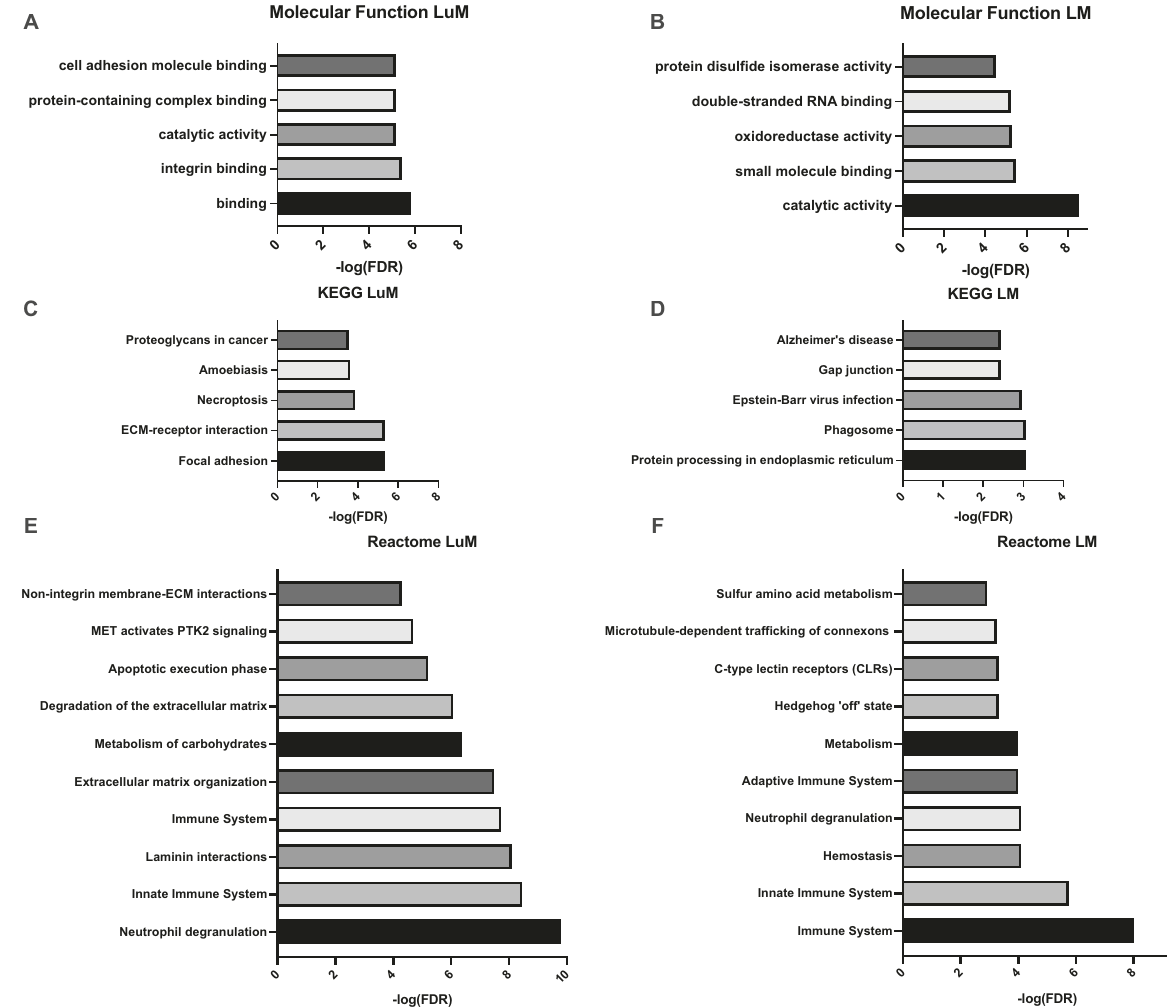
Fig. 5 Molecular function and pathway (KEGG and REACTOME) annotations of LM and LuM CD11b + cells. LuM and LM proteins were annotated for Molecular function ( A , B ), KEGG ( C , D ), and Reactome Pathways ( E , F ), respectively. Druggable proteins with matching transcriptomic were annotated for function and major pathway associations using STRING. False discovery rate threshold was set to